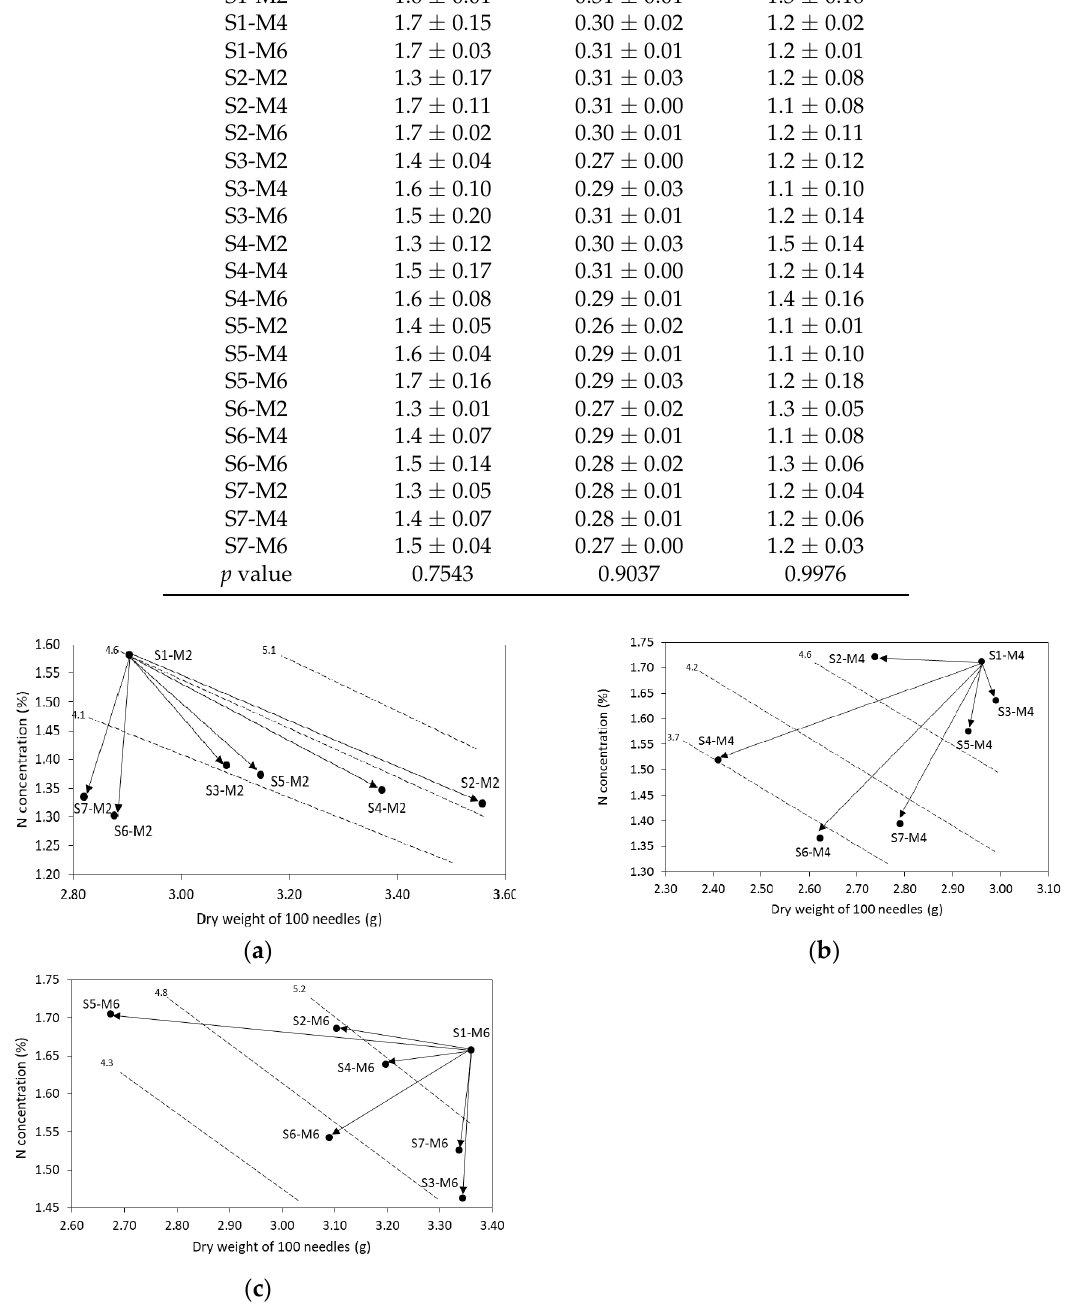
Figure 3. Nomograms of nitrogen (N) concentration vectors in the foliage of Pinus engelmannii , produced on seven substrates with the addition of three fertilization doses: ( a ) 2 g L − 1 Multicote ® , ( b ) 4 g L − 1 Multicote ® and ( c ) 6 g L − 1 Multicote ® .